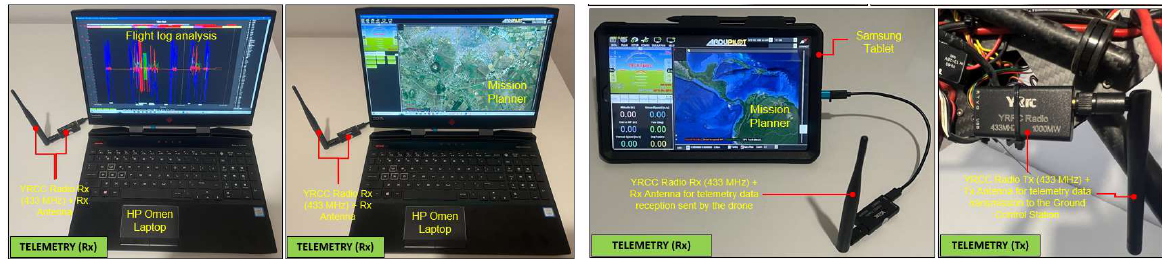
Figure 7. Arrangement of the telemetry kit on the drone and on the